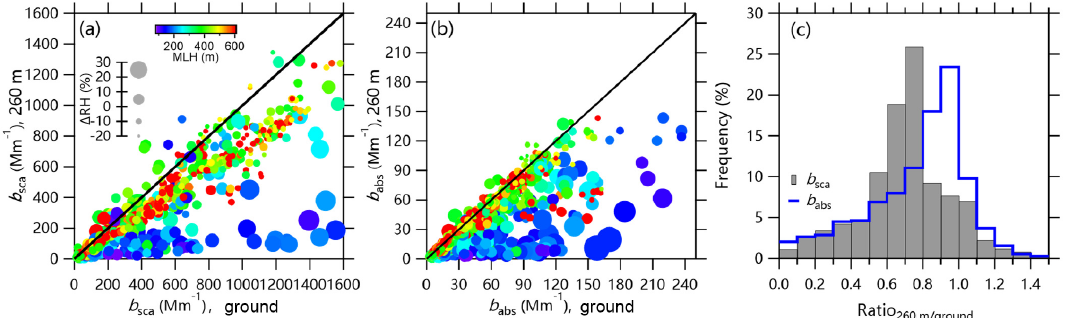
Figure 4. Comparisons of (a) b sca and (b) b abs between 260m and ground level. The scatter plot is color coded by mixed layer height, and the marker size is proportional to the RH difference between ground level and 280m. Panel (c) shows the frequencies of ratios of 260m to ground level for b sca and b abs .